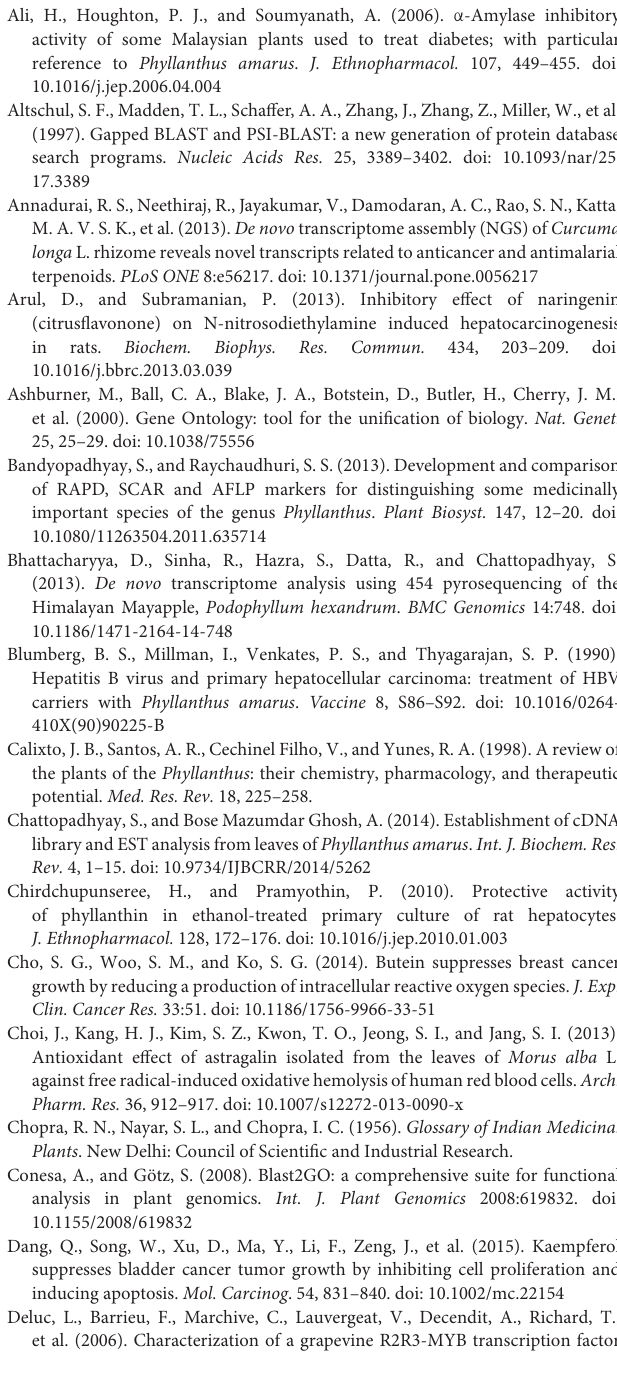
Supplementary Figure 4 | Tropane, piperidine, and pyridine alkaloid biosynthetic pathway genes identified. Supplementary Figure 5 | Putatively identified genes of diterpenoid biosynthesis